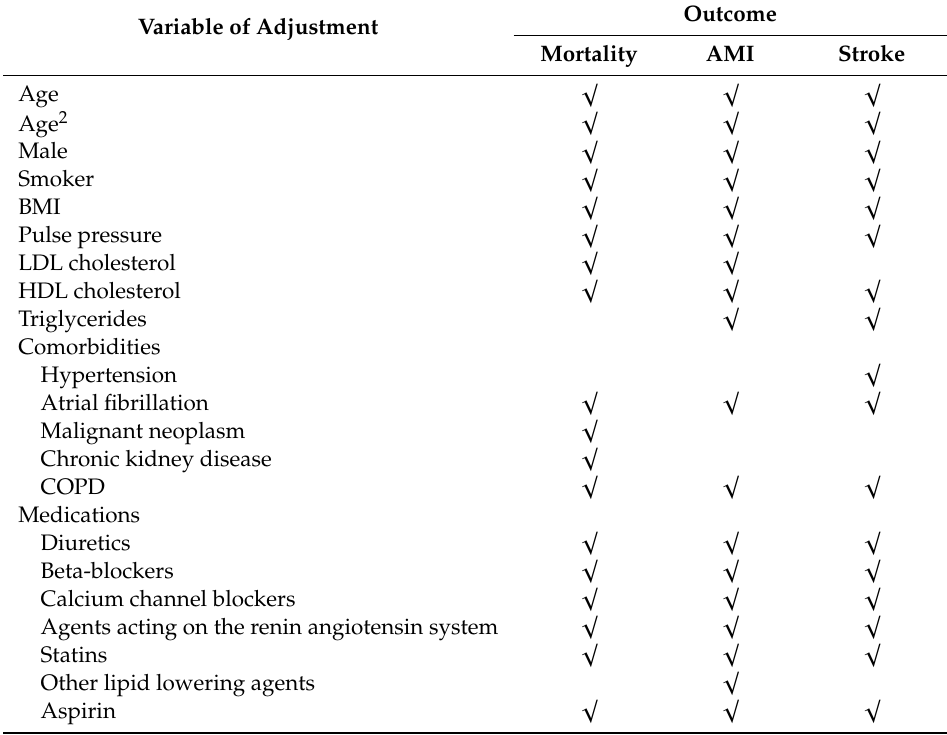
Table A4. Variables of adjustment in the Cox proportional hazard models for each outcome. Variable of Adjustment